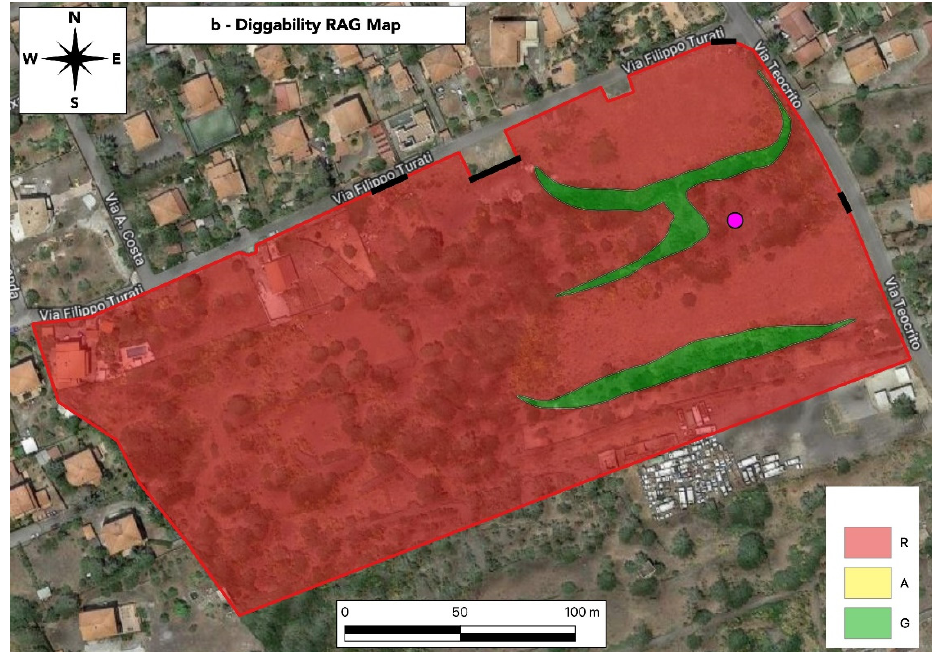
Figure 13. RAG map of the “Diggability” layer of the GIS platform. The burial site (pink circle) fell on the Red coded area. For the percentages of RAG color-coded areas see Figure 11 (the Amber-coded area is not visible covering the 1% along the Red and Green area boundary).